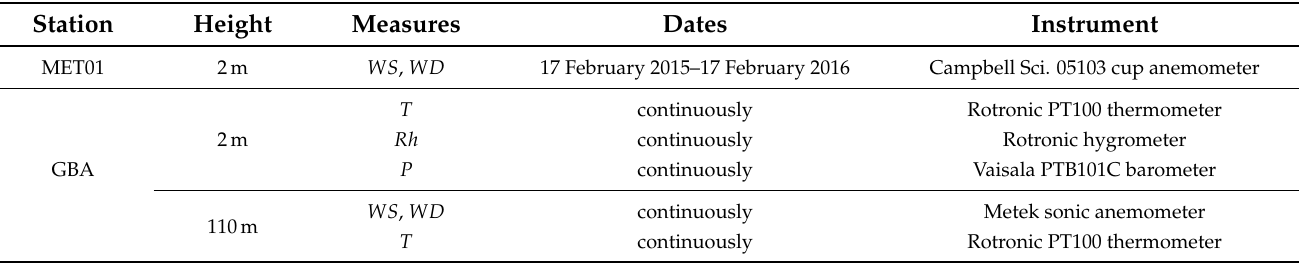
Table 1. Summary of observations made in the Cadarache valley. T indicates temperature; P pressure; Rh relative humidity; WS wind speed; WD wind direction. The height of measurement is above ground level. See Figure 1c for stations locations.